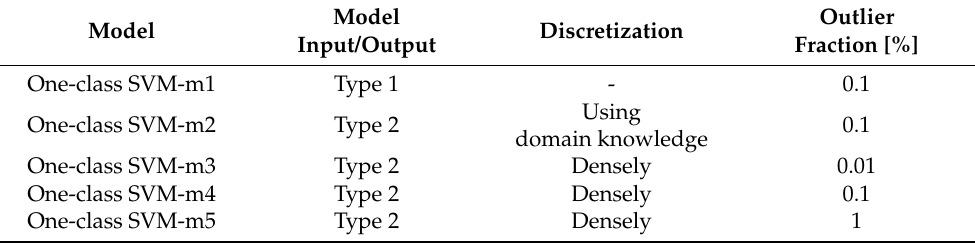
Table 8. Hyper parameter settings for the one-class SVM-based anomaly detection